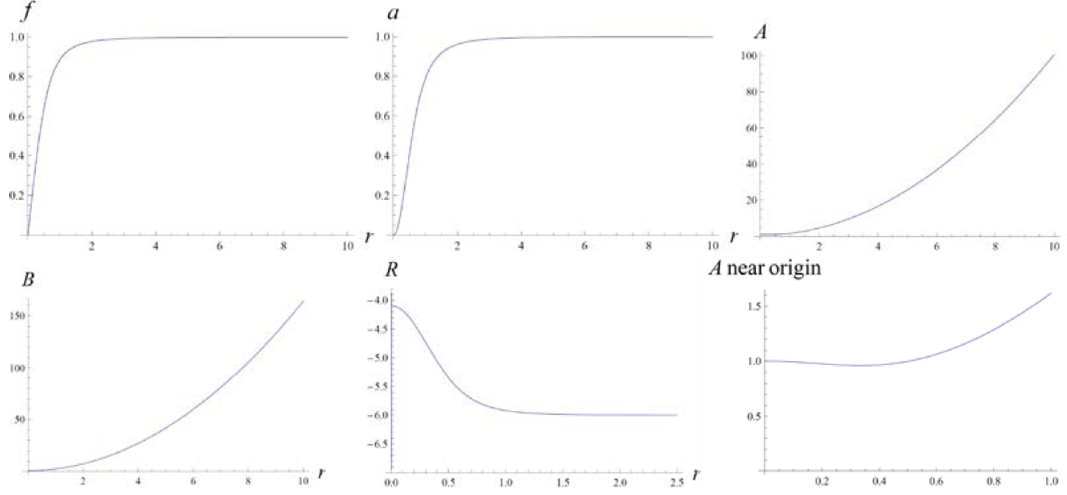
Figure 1 . Case I: n = 1 , v = 1 and Λ = − 1 . The matter functions f and a plateau at their respective values of v = 1 and n = 1 . The metric functions A and B are positive throughout and hence there is no event horizon (this fact will be true of the next four figures so we will not repeat it later). The Ricci scalar plateaus at − 6 which agrees with the expected 6Λ . The numerical value of the metric function A at R = 10 is 100 . 588 while the value of A 0 at R = 10 can be evaluated analytically via − Λ r 2 + 1 and yields 101 . The mass obtained from (3.4) is then M = 2 πα (101 − 100 . 588) = 2 . 589 where α = 1 was used. The integral mass formula (3.7) for the matter profiles plotted here yields M = 2 . 587 . The two masses agree to within two decimal